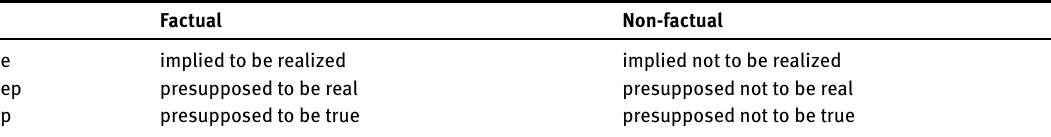
Table 3. Presupposedness parameter (Hengeveld 2014, Hengeveld in